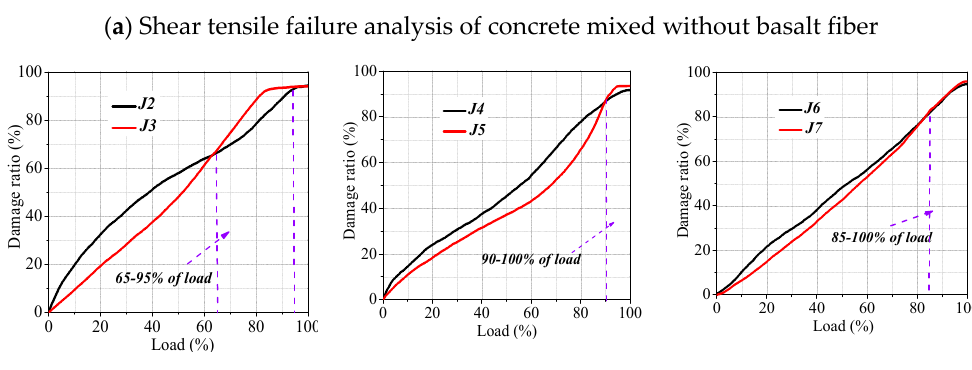
( b ) Shear tensile failure analysis of concrete mixed with basalt fiber Figure 12. Shear tensile failure analysis of concrete mixed with and without fiber. Figure 12. Shear tensile failure analysis of concrete mixed with and without